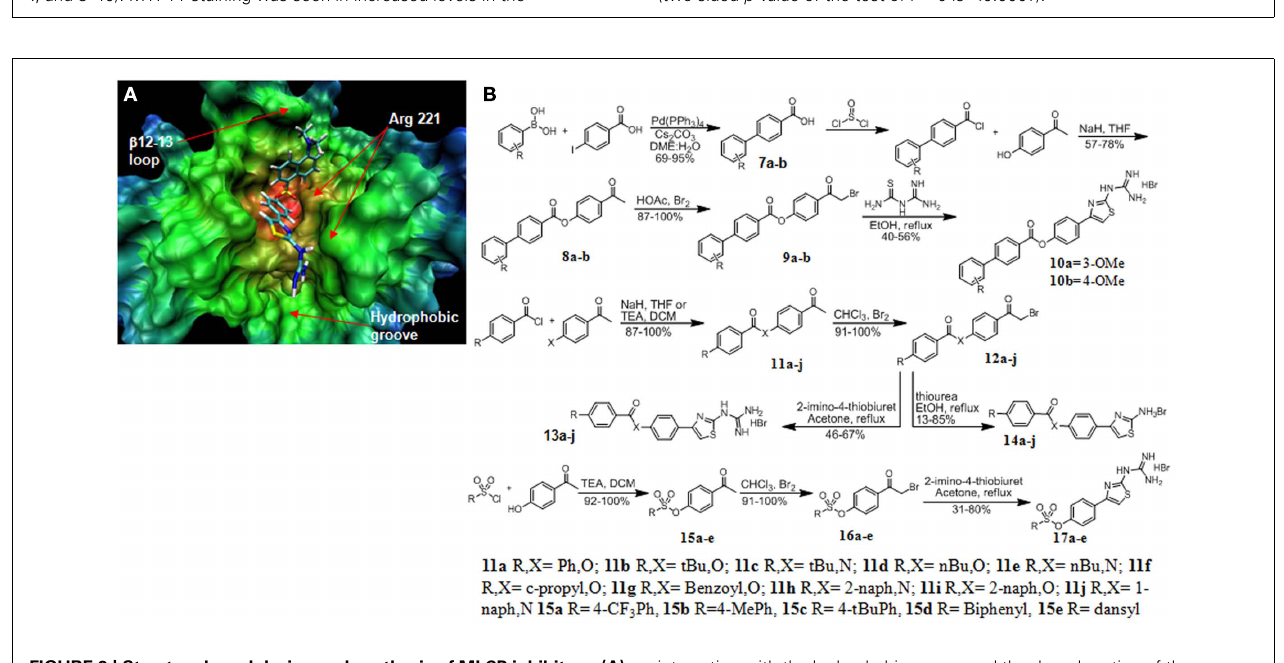
FIGURE 3 | Structure based design and synthesis of MLCP inhibitors. (A) 17e docked into the crystal structure of PP1C showing the guanidine group